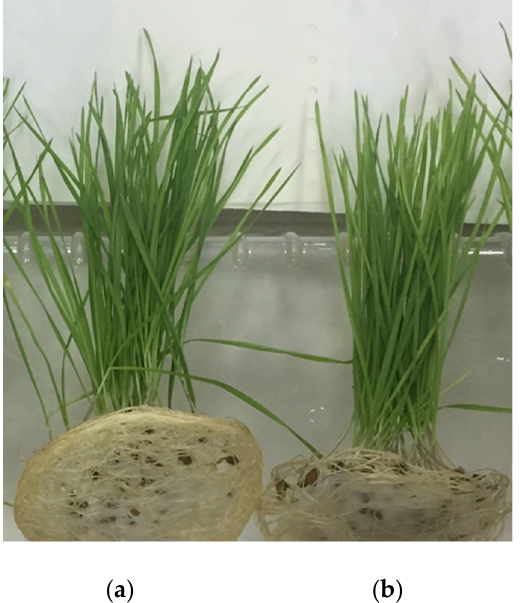
Figure 5. Photographs of PHB ( a ) and 85PHB/15NBR ( b ) nonwoven samples after a germination of wheat plants on the 12th day of vegetation.